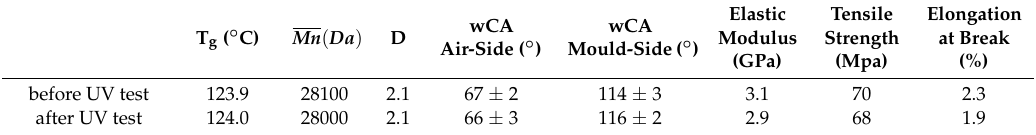
Figure 1. Synthetic route for MMA_ α -methylstyrene_POMA ter-polymer. Table 1. Main physicochemical (glass transition temperature, T g ; number average molecular weight, Mn ; molecular weight distribution, D; water contact angles, wCA) and mechanical properties (elastic Young’s tensile modulus, tensile strength, elongation at break) of the MMA_ α -methylstyrene_POMA ter-polymer before and after the UV stability